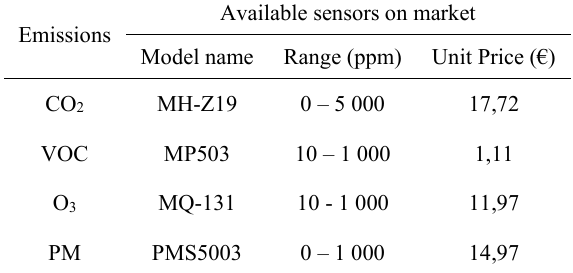
Table 1. Emission sensors: market price